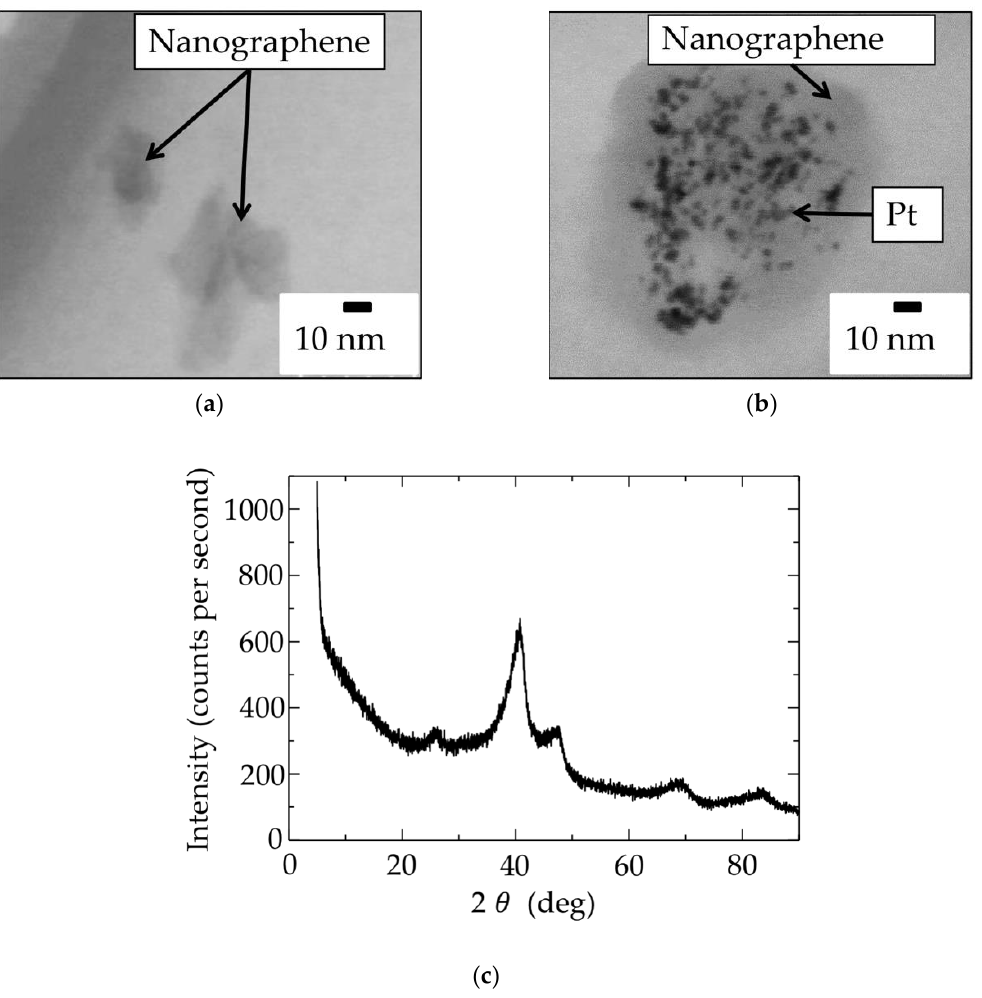
Figure 3. Transmission electron microscope (TEM) images of synthesized nanographene ( a ), nanographene loaded with Pt nanoparticles ( b ) and XRD spectrum of Pt nanoparticles supported nanographene ( c ).